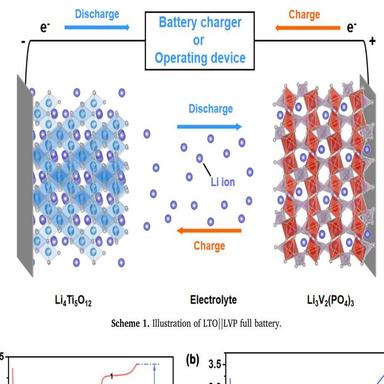
(a) Voltage matching principle and (b) discharge/charge profiles for the LTO||LVP battery.